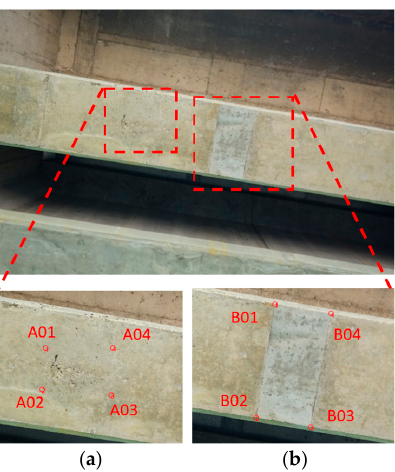
Figure 18. Damage at the bottom of the main beam at the test site: ( a ) incomplete concrete grouting (hive phenomenon); ( b ) refilled concrete.